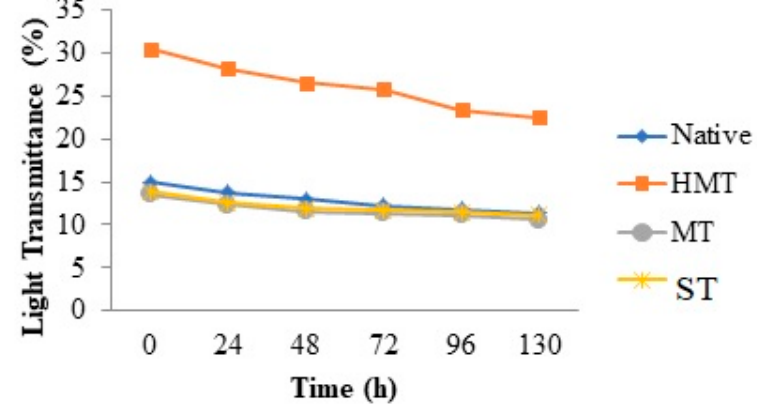
Figure 1. Light transmittance of native and modified